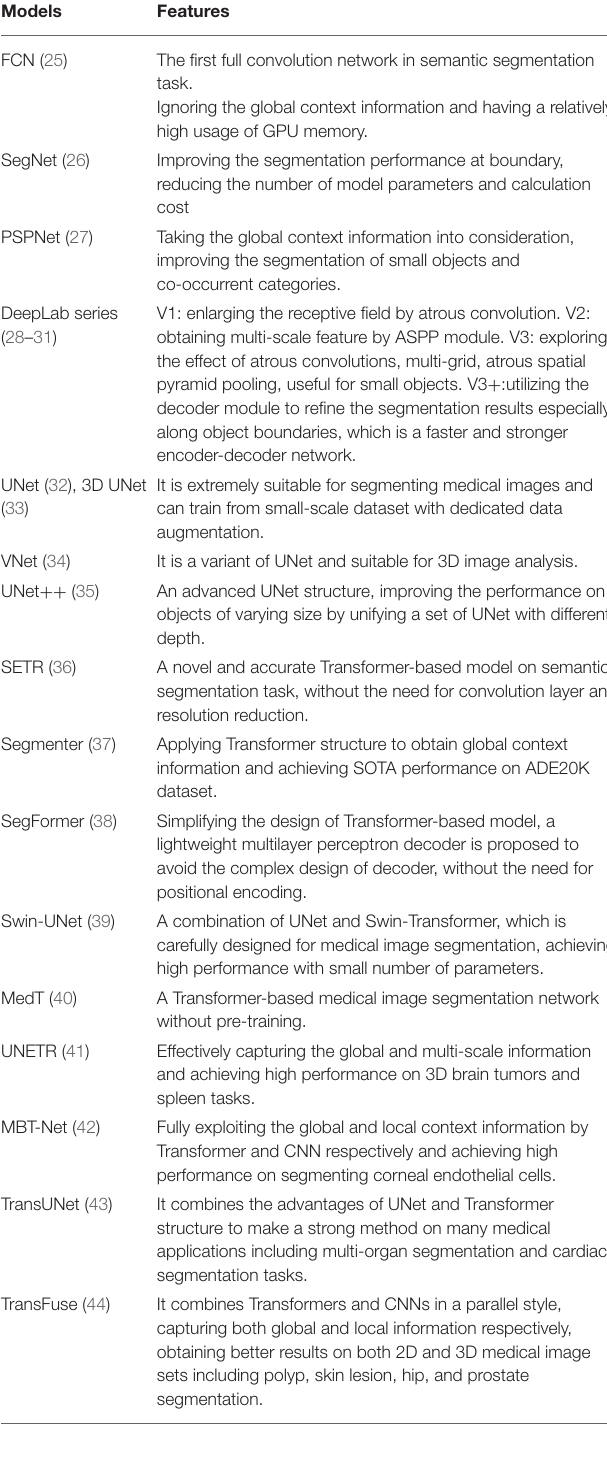
TABLE 2 | Features of semantic segmentation algorithms. Models